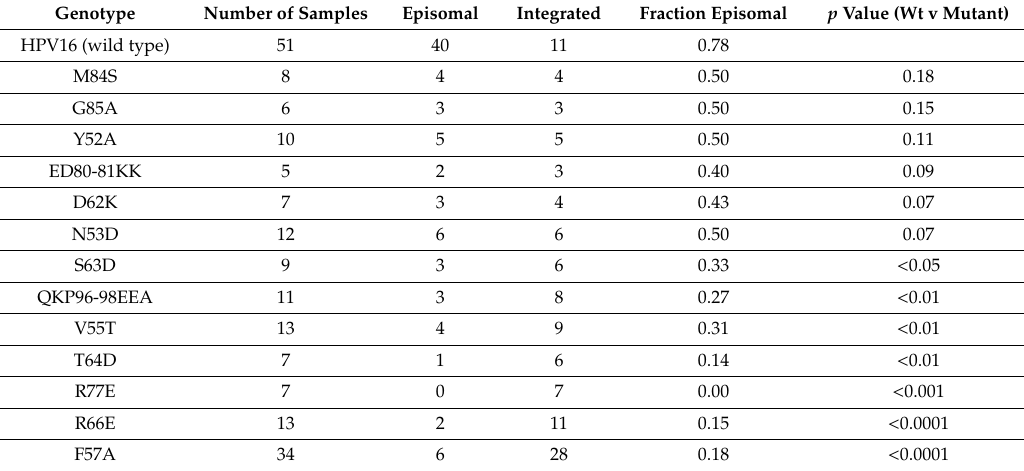
Table 1. Tabulation of Southern blots showing episomal maintenance of viral DNA in wild type HPV16 + or CR3 mutant